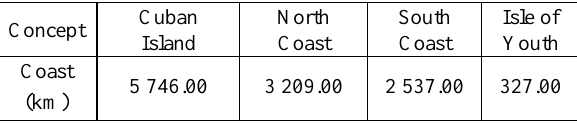
Table 3. Official data published in the Statistic yearbook of